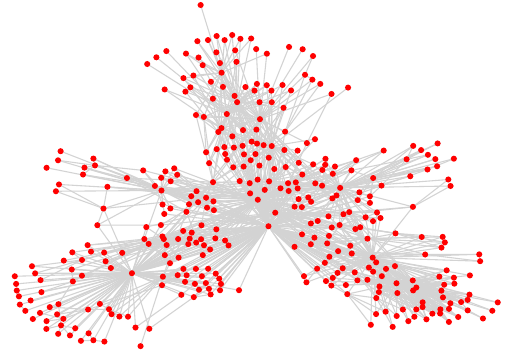
Figure 4 The graph-representation of segments